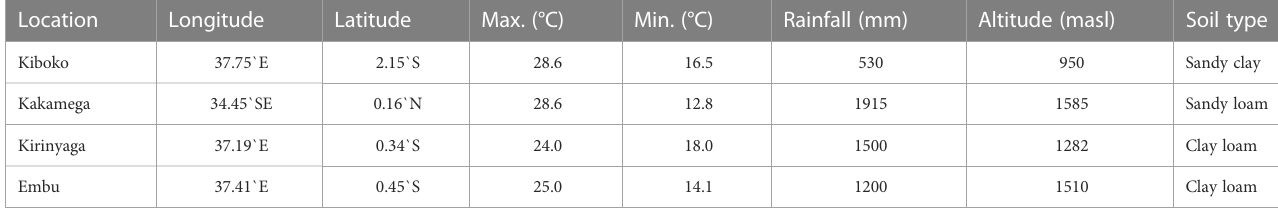
Masl, meters above sea level; mm, millimeter.